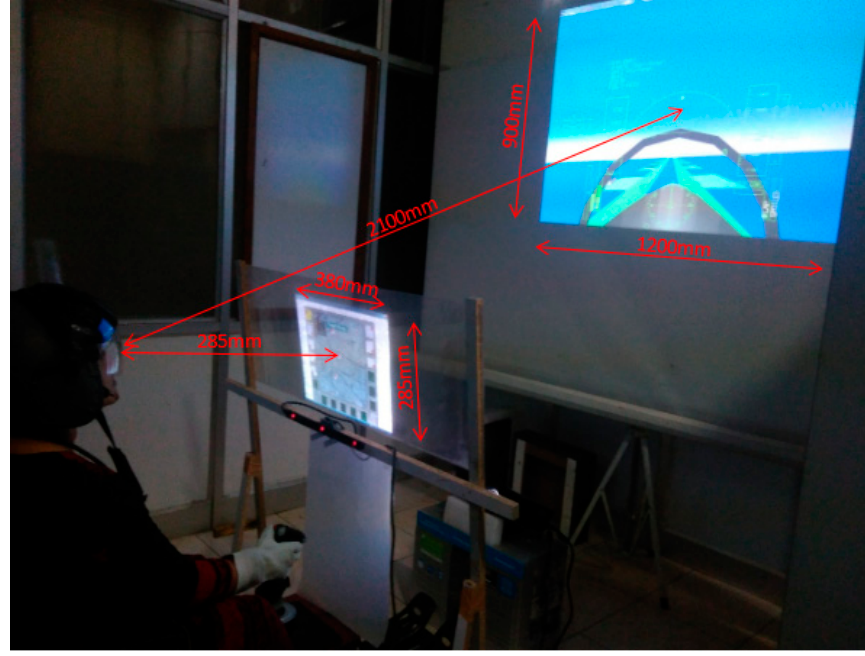
Figure 32. Experimental setup for the flight simulator.